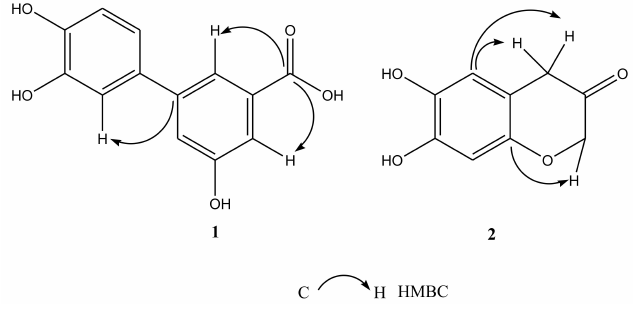
Figure 2. Key HMBC correlations of compounds ( 1 )–( 2 ) (C–H). Table 1. 13 C NMR data of compounds 1–2 (125 MHz; in DMSO) ( δ ppm).